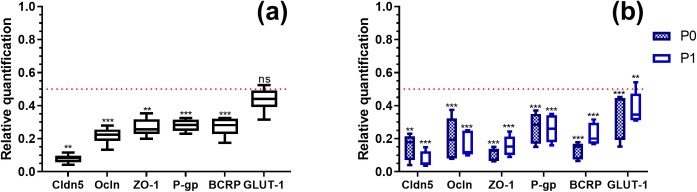
Relative quantification of the mRNA of junction and transporter proteins in primary endothelial cells.Analysis of the mRNA expression of (a) junction proteins: claudin-5 (Cldn5), occludin (Ocln), zonula occludens-1 (Tjp1; ZO-1) and transporter proteins: P-glycoprotein-1 (P-gp), breast cancer resistance protein (Bcrp; ABCG2) and glucose transporter-1 (Glut-1; SLC2A1) in endothelial cells at passage 1 (P1) assessed by q-PCR. The results are represented as relative values to P0. (b) The relative mRNA expression levels of junction and transporter proteins in P0 and P1 ECs, inflamed with 100 U/mL of TNF-α and IFN-γ for 24h. The results are relative to the corresponding untreated EC passages. All results were first normalized with Hprt/Gapdh/Tbp mRNA levels. The results are represented as the means ± standard deviations of 6 replicates. The dotted red lines represent a fold change of 0.5, underneath which, values were considered biologically significantly changed. Stars show significative differences between tested conditions and their corresponding base values. t-test: * P-value ≤ 0.05, ** P-value ≤ 0.01, *** P-value ≤ 0.001.